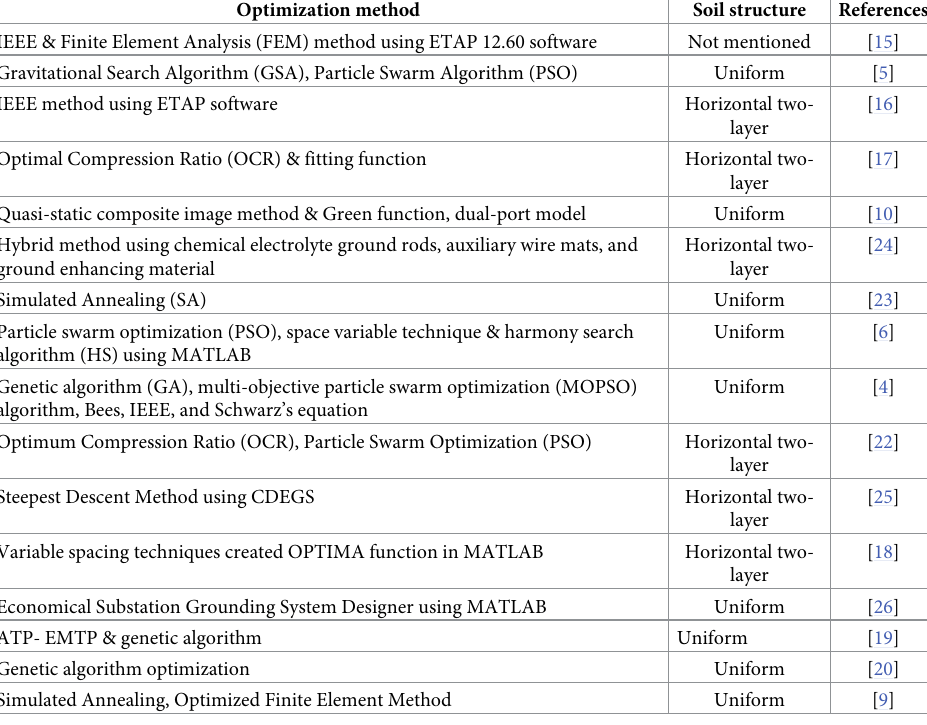
Table 1. Optimization methods used in the grounding